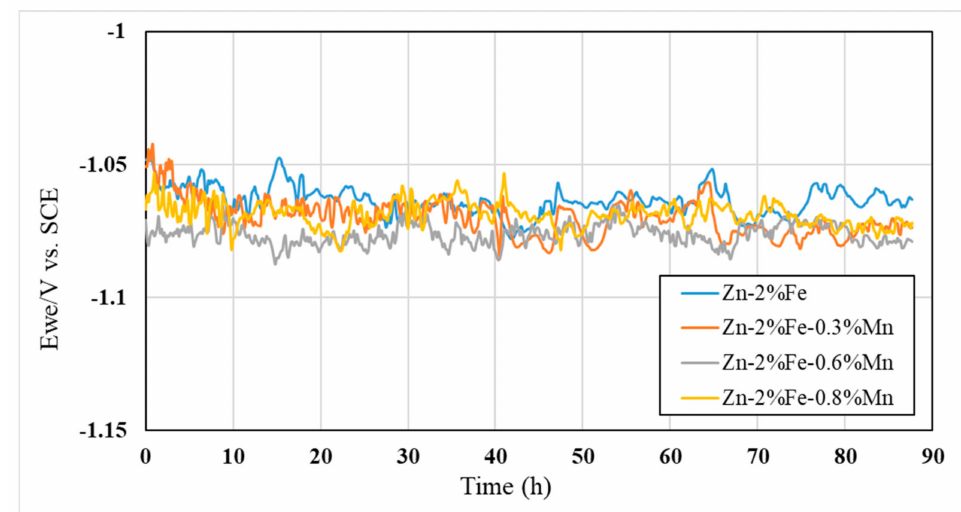
Figure 9. Open circuit potential of tested alloys in PBS